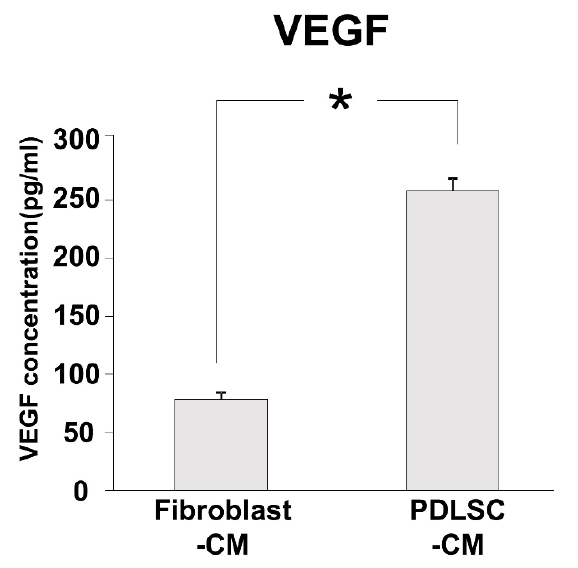
Figure 6. The concentration of VEGF in CM. Concentrations of the angiogenesis-related growth factor, VEGF, in Fibroblast-CM and PDLSC-CM. A greater amount of VEGF was found in PDLSC-CM than in Fibroblast-CM. (* p < 0.05) (CM = conditioned medium, PDLSCs = periodontal ligament stem cells, VEGF = vascular endothelial growth factor). Experiments were performed in triplicates, and data from an independent experiment performed three times were shown. ( n = 3).